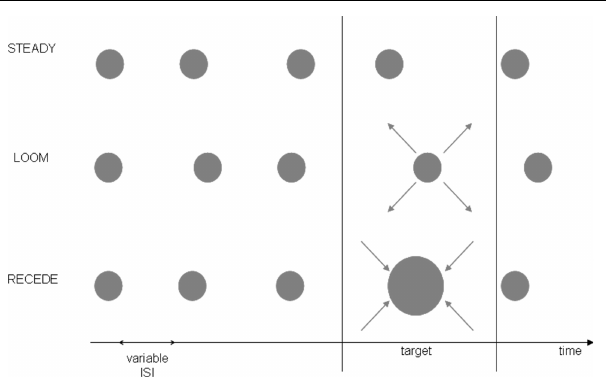
FIGURE 1 | Experimental Design. The pre-fMRI training session consisted of three conditions (LOOM, RECEDE, STEADY) whereas the fMRI session tested the two main conditions (LOOM, RECEDE). One trial consisted of a stream of fi ve visual events, four standards and one target. All standards were static discs of ∼ 500 ms duration; all targets were presented at the fourth position in the stream and varied in duration. In the pre-fMRI session, a target could be a static (steady), a looming or a receding disc. In the fMRI session, a target was either looming or receding. The inter-stimulus intervals (ISI) and the inter-trial intervals (ITI) were all variable.